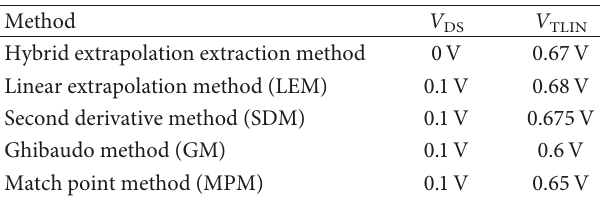
Table 1: Comparison of V TH extraction methods for 10nm test